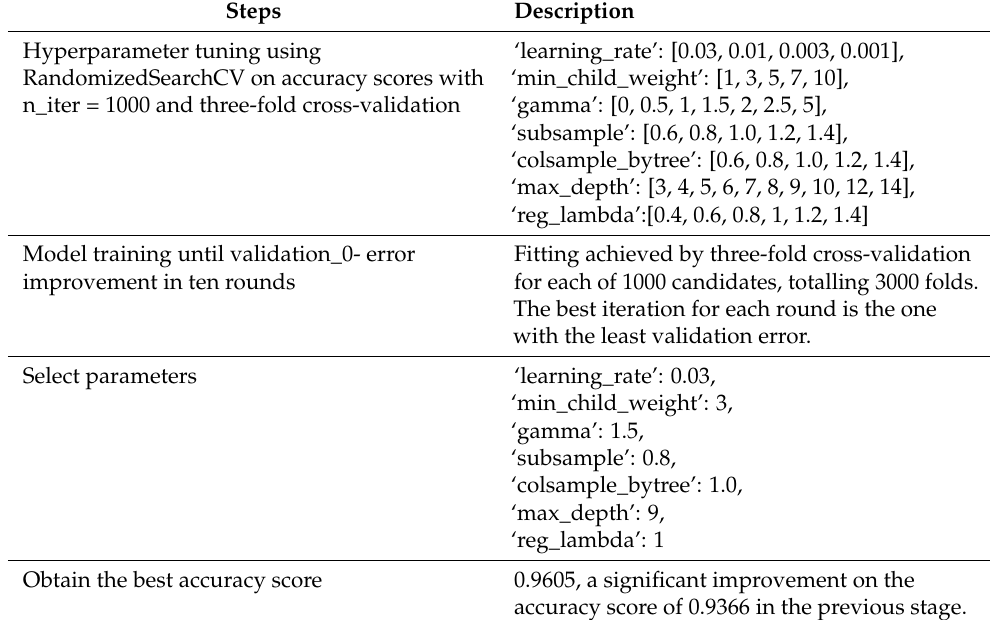
Table 4. XGBoost optimization process. Steps Description Hyperparameter tuning